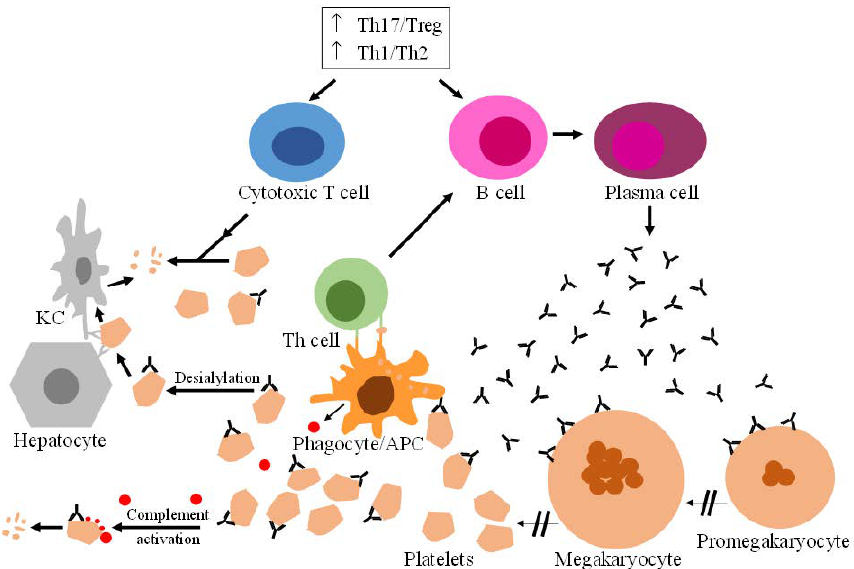
Figure 1. Mechanisms of platelet destruction in ITP. The immune imbalance leads to the excessive activation of cytotoxic T cells and autoreactive B cells. Plasma cell formation induces the release of antiplatelet autoantibodies. As a result, the opsonized platelets are destroyed by phagocytes, which can also present antigens to Th cells. Opsonized platelets can also be destroyed by the complement system; their surface glycoproteins are exposed to desialylation. This leads to subsequent platelet cleavage in the liver by Kupffer cells, after binding hepatocytes via Ashwell – Morell receptors. Finally, autoantibodies also interfere with platelet generation from megakaryocytes in the bone marrow. Note: APC, antigen presenting cell; KC, Kupffer cell.